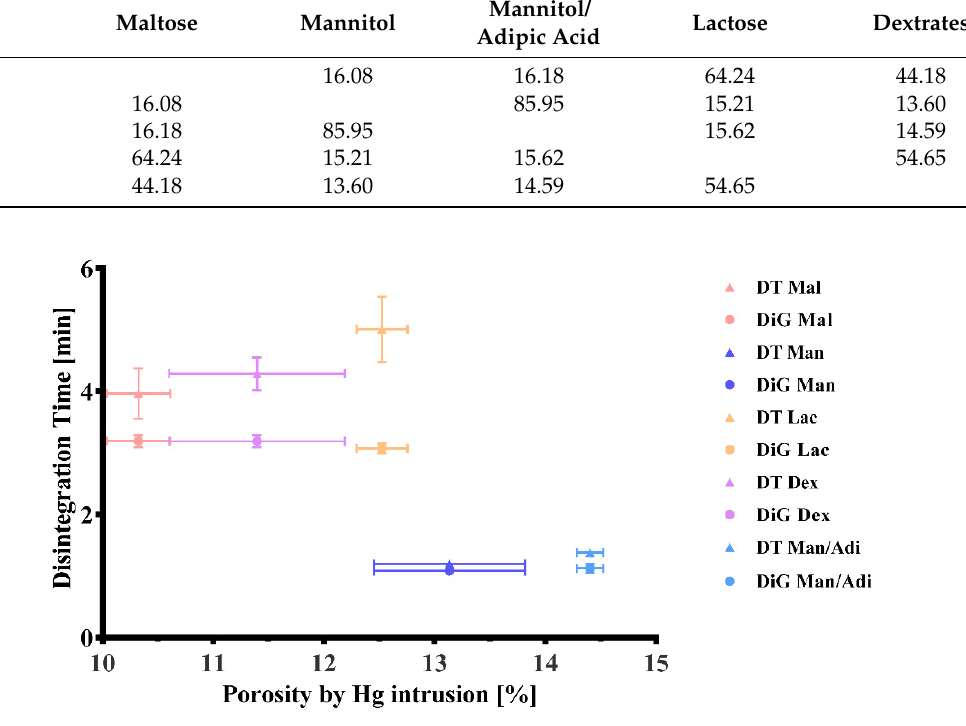
Figure 3. Disintegration time vs. porosity. Experiments were conducted in a beaker with 200 mL of water as described in the monograph of effervescent tablets in the Ph. Eur. 10.1/0478. Primary and secondary endpoints of disintegration were determined visually. The first measurement was taken when the tablet had partially disintegrated into granular particles (DiG = partial disintegration into granular particles). The second measurement was taken as the endpoint, after the tablet and the particles had disintegrated completely (DT = disintegration). These values were recorded for different fillers (Mal = maltose; Man = mannitol; Lac = lactose; Dex = dextrates; Man/Adi = mannitol/adipic acid) and were plotted against the porosity of the tablets, which was measured by mercury